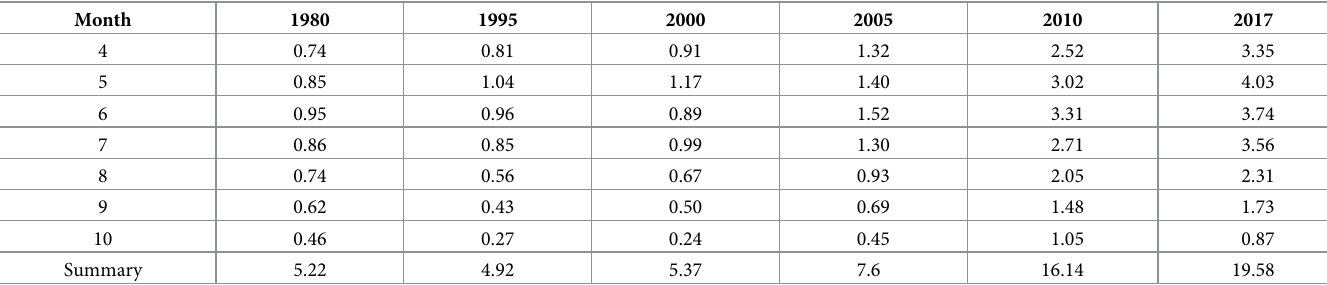
Table 5. WFs of the forest from April to October in different years (billion m3).